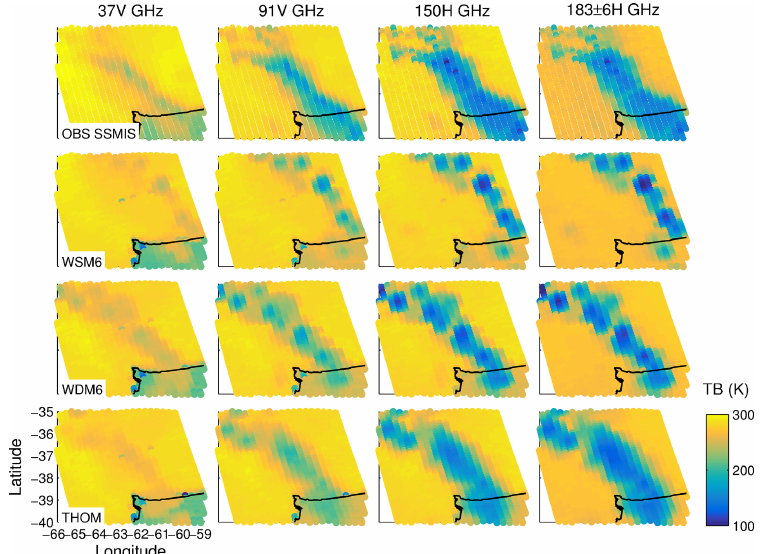
Figure 20. SSMI/S observations, as compared to the corresponding radiative transfer simulations using the dendrite habits for the WSM6, WDM6 and THOM scheme simulations for the 13 January 2011 event